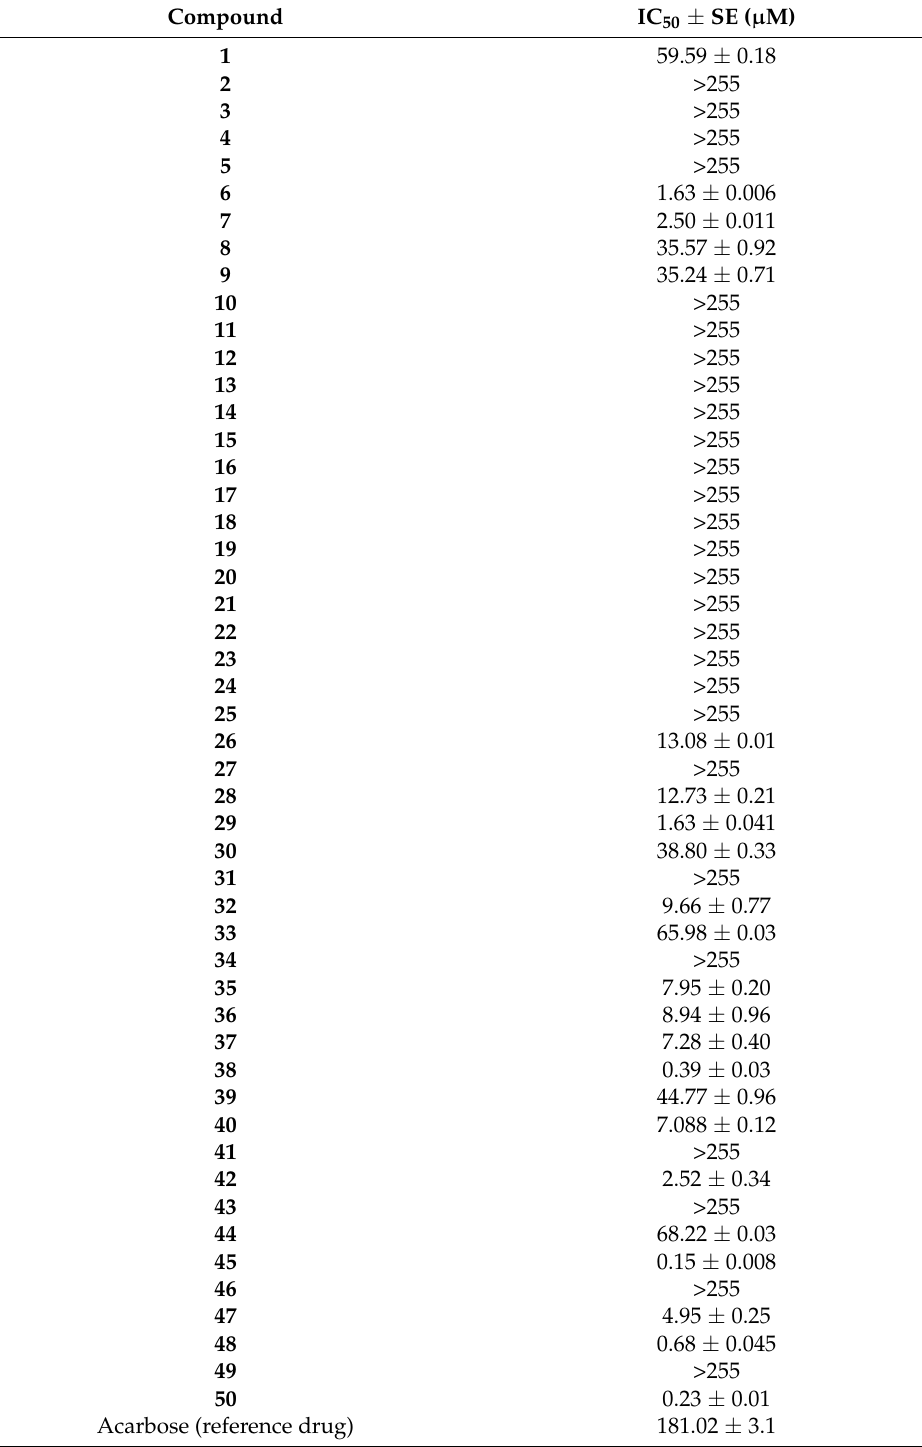
Table 1. α -Glucosidase inhibitory potential of the synthesized compounds 1–50